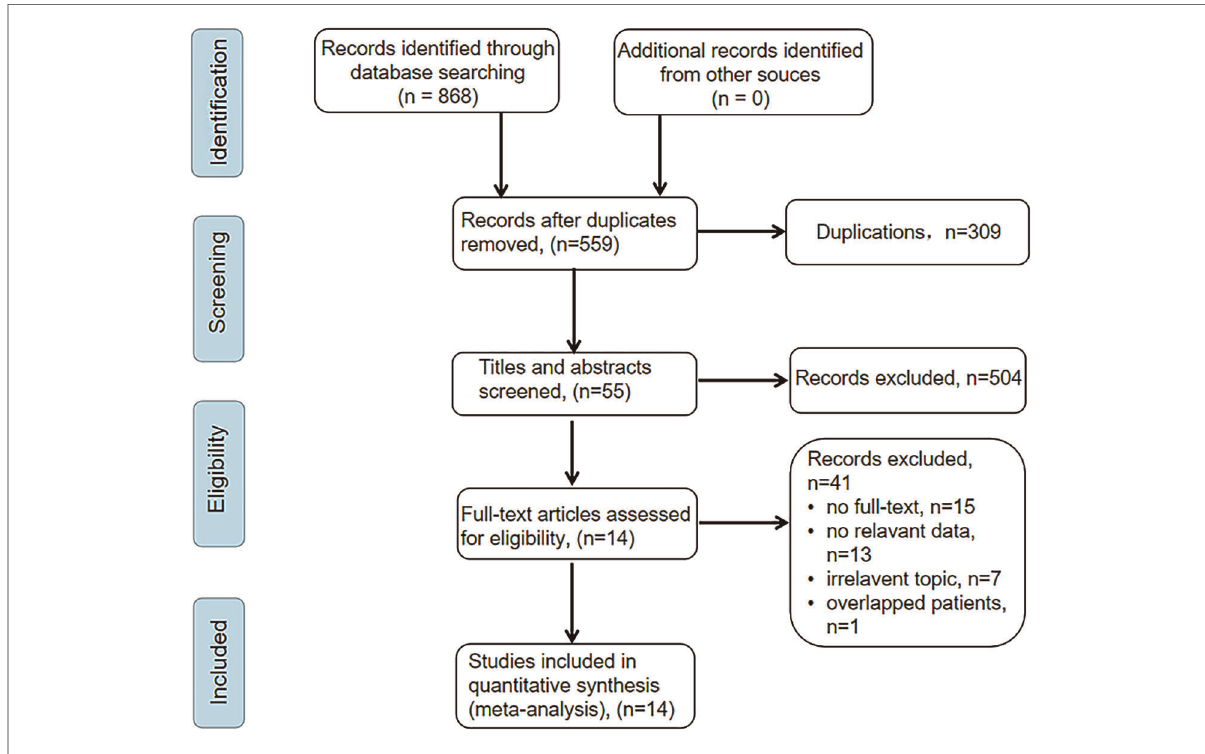
FIGURE 1 PRISMA fl ow diagram of eligible studies